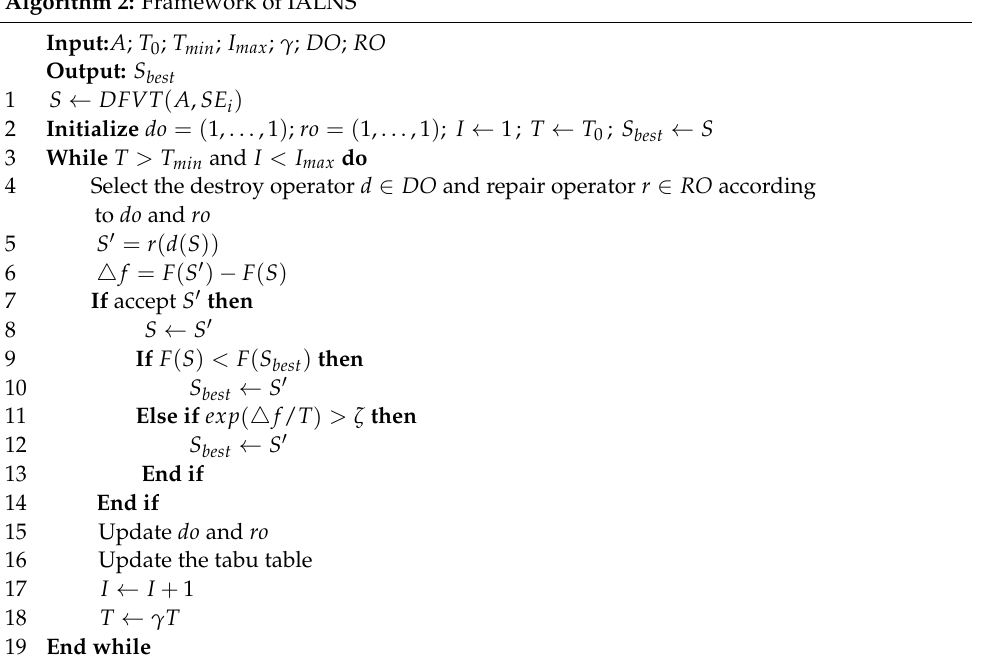
Algorithm 2: Framework of